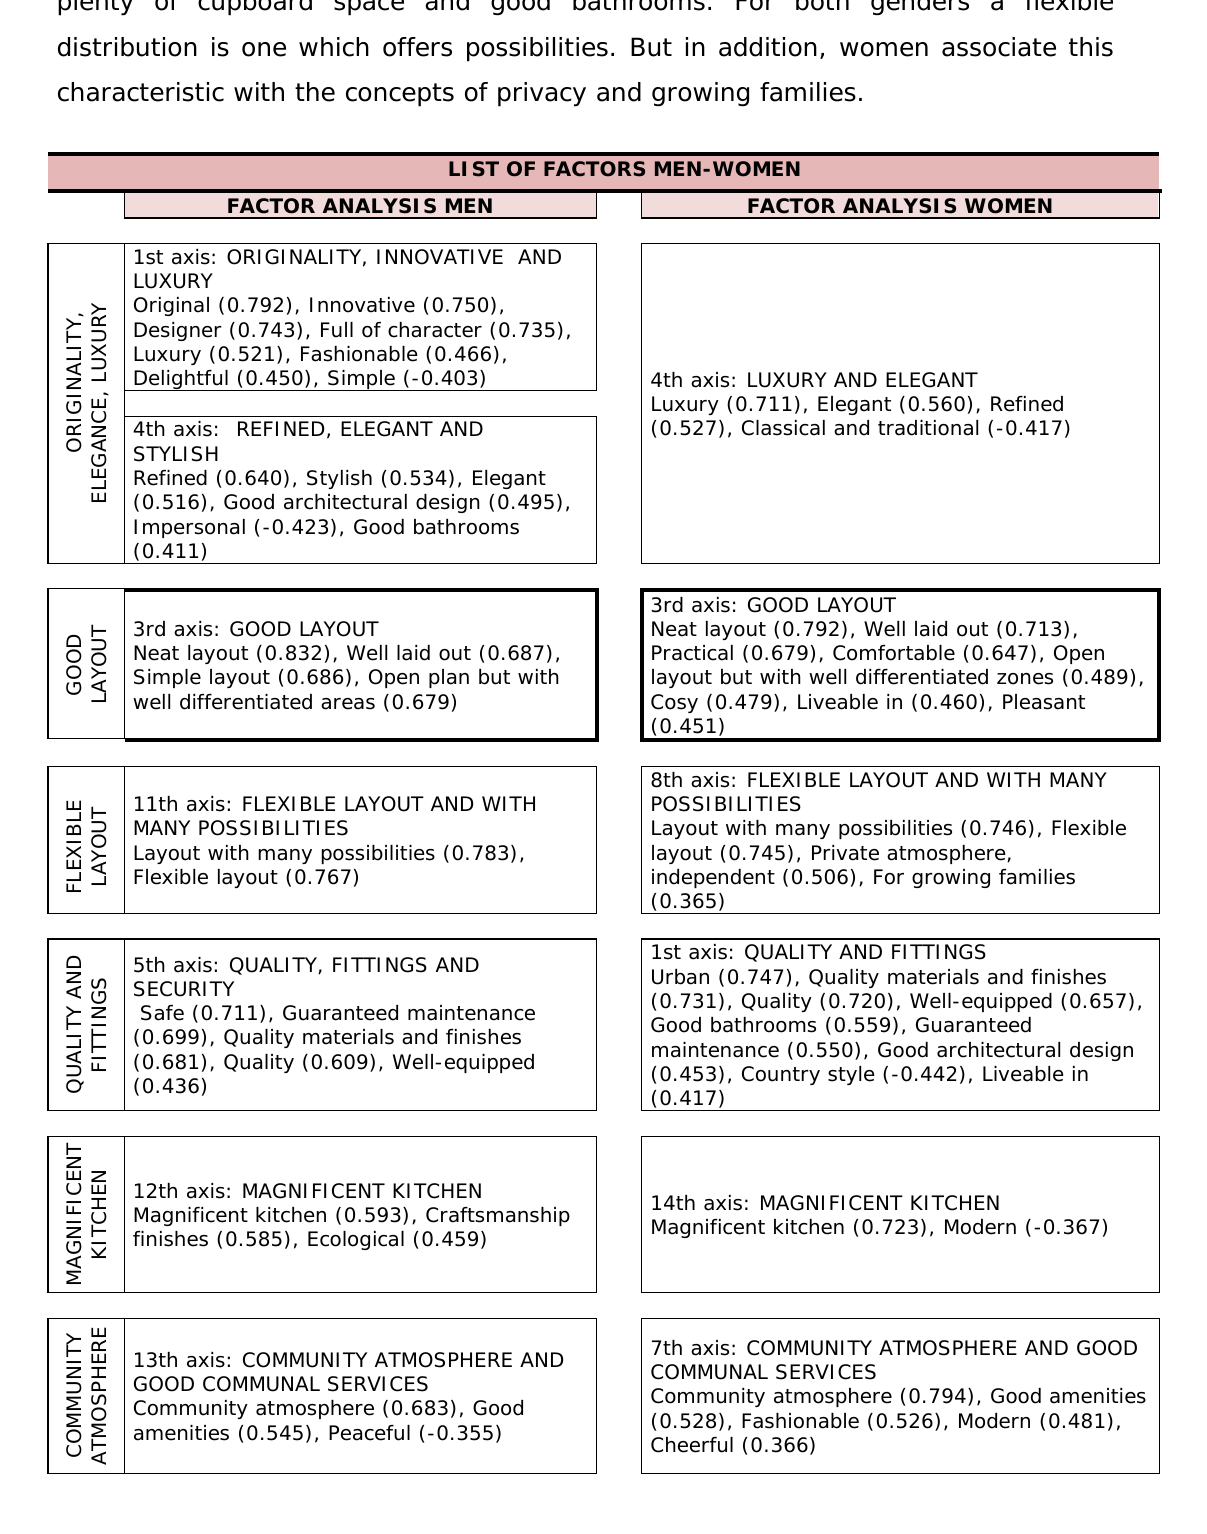
7th axis: COMMUNITY ATMOSPHERE AND GOOD COMMUNAL SERVICES